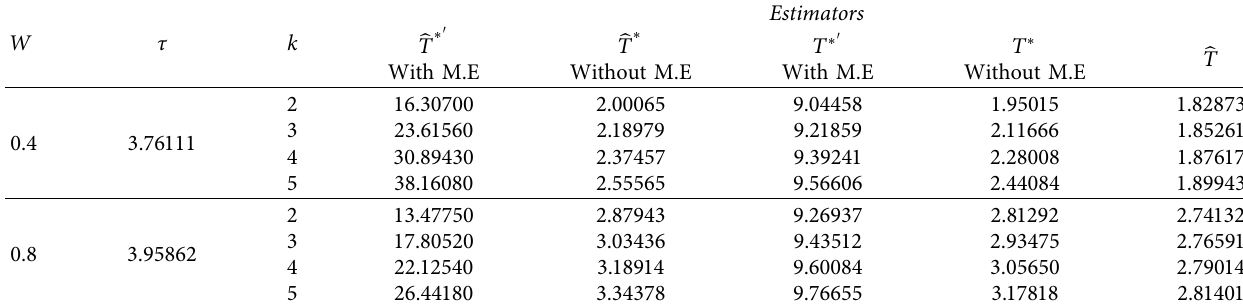
Table 4: MSE of the proposed estimators with nonresponse and measurement errors for diferent values of k and W . 􏽢 T ∗′ 􏽢 T ∗ T ∗′ T ∗ W τ k With M.E Without M.E With M.E Without M.E 2 0.4 2.47430